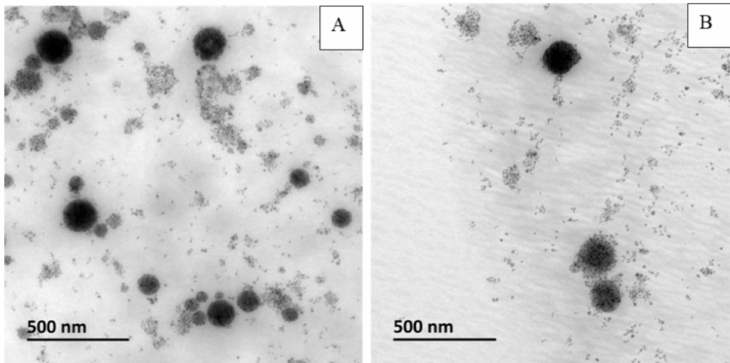
Figure 7. TEM image of MCLs prepared with: ( A ) 2.5 mM (REV_MCL_2.5) or ( B ) 10 mM (REV_MCL_10) of